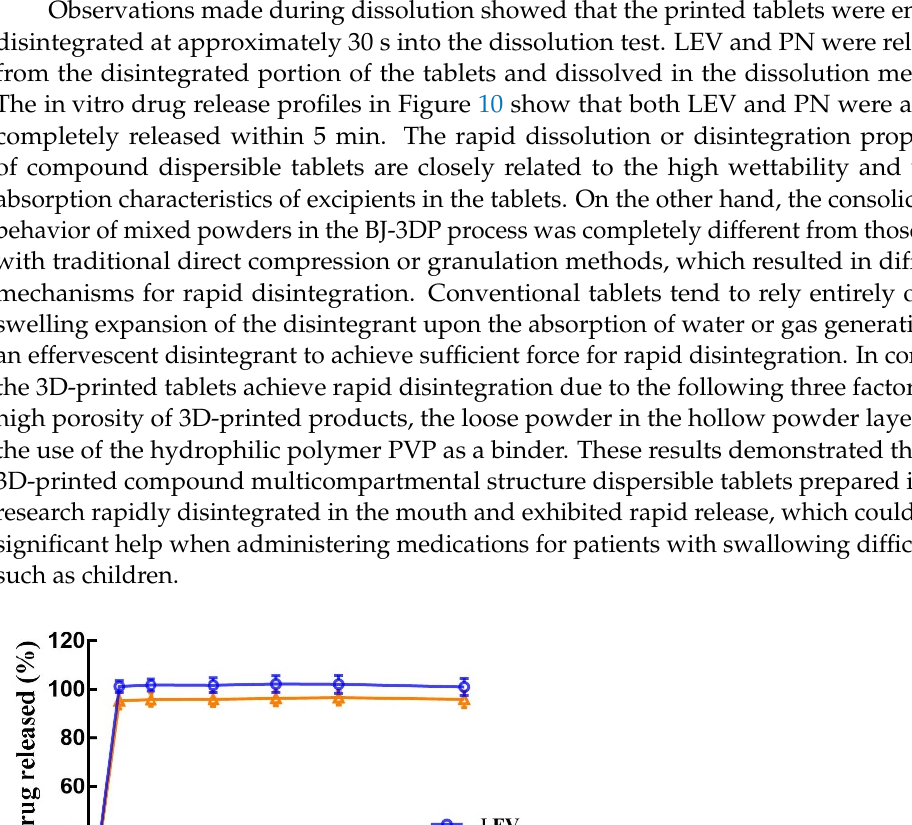
Figure 9. Internal pore size distribution of 3D-printed compound dispersible tablets.